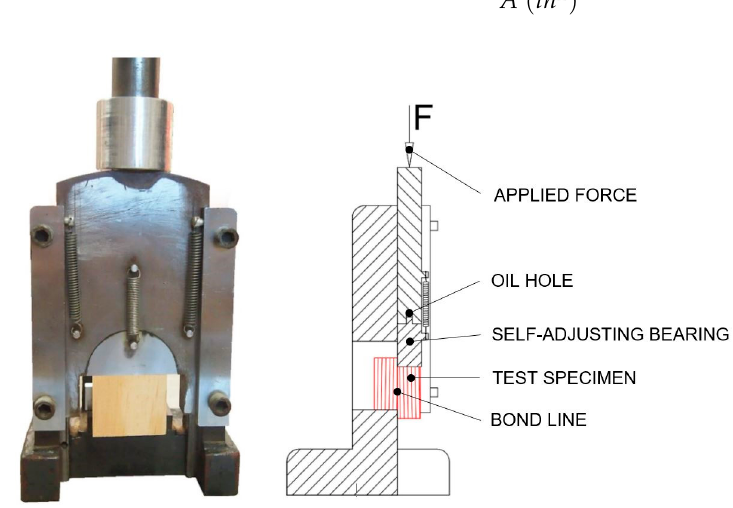
Figure 3. Test specimen set-up in self-adjusting shearing tool.